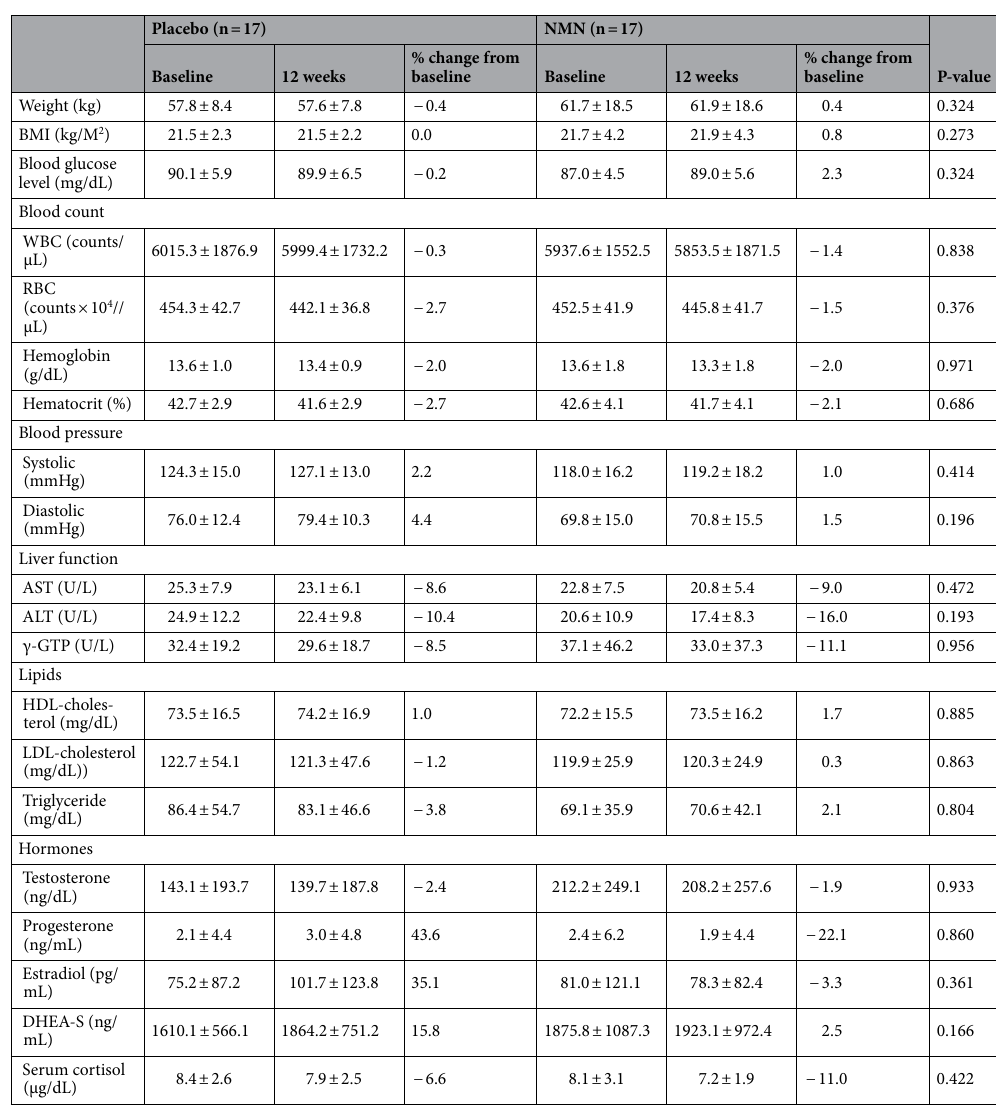
Table 2. Body composition and metabolic parameters of the placebo and NMN intake groups before and after the intervention period. Values are presented as mean ± standard deviation. Primary efficacy variables were statistically analyzed using a full-analysis-set population. Analysis of covariance (ANCOVA) was applied for significance between the two groups using the baseline as a covariate. Statistical significance was set at p < 0.05. NMN nicotinamide mononucleotide, BMI body mass index, WBC white blood cell, RBC red blood cell, AST aspartate aminotransferase, ALT alanine aminotransferase, γ-GTP γ-glutamyl transpeptidase, HDL high- density lipoprotein, LDL low-density lipoprotein, DHEA - S dehydroepiandrosterone